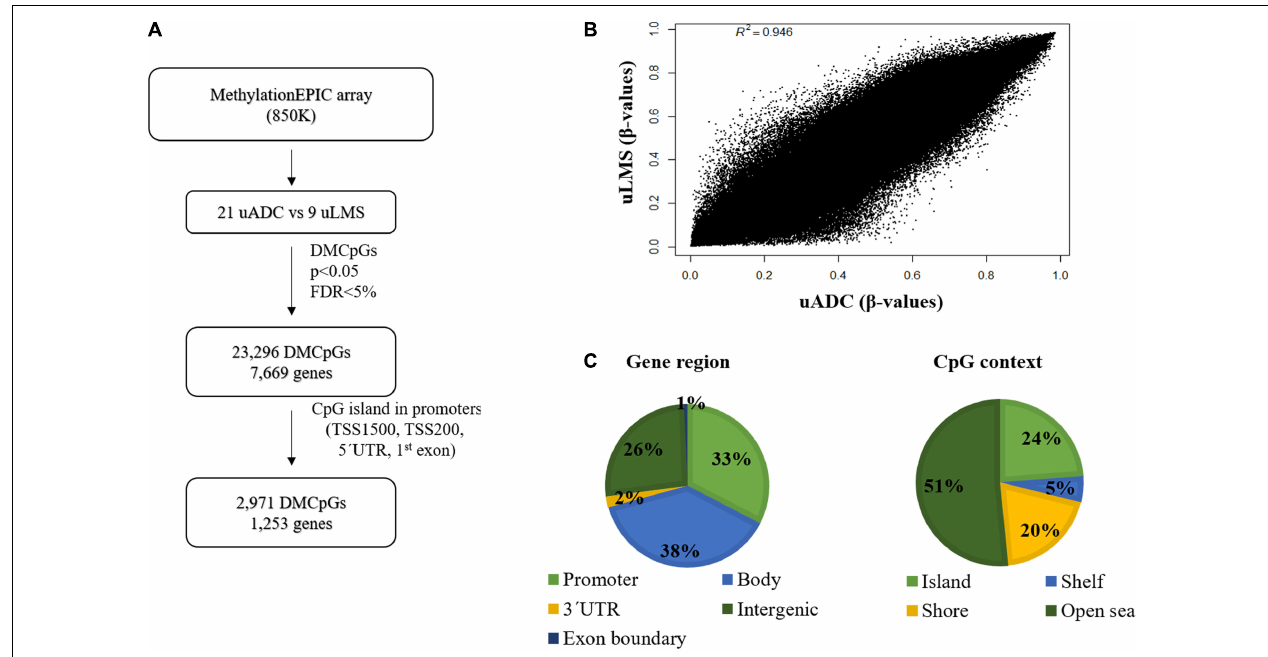
FIGURE 6 | Genome-wide DNA methylation analysis in invasive tumor front (ITF) of primary uterine adenocarcinomas (uADC) and leiomyosarcomas (uLMS) shows a small proportion of CpGs with differential methylation pattern. (A) Schematic flowchart used to identify differentially methylated CpGs (DMCpGs) in primary ITF between uADC and uLMS. (B) Scatter plot representing mean normalized levels of DNA methylation ( β -values) in primary ITF of uADC and uLMS. (C) Genomic distribution of 23,296 differentially methylated CpGs (DMCpGs) in primary ITF of uADC and uLMS, in relation to their respective location regarding CpG context and gene